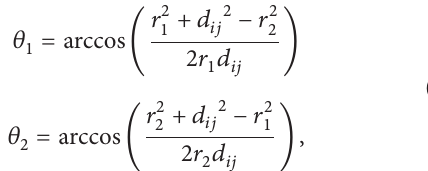
algorithm for AP deployment based on physical distance